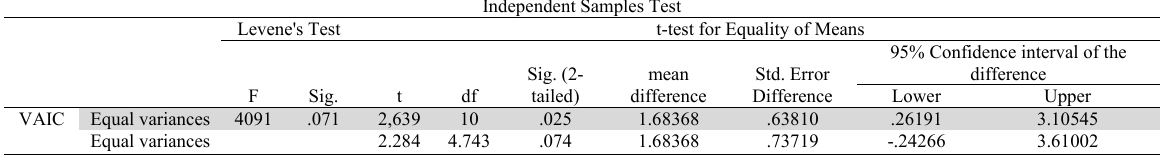
Test different independent sample test VAIC Independent Samples Test Levene's Test t-test for Equality of